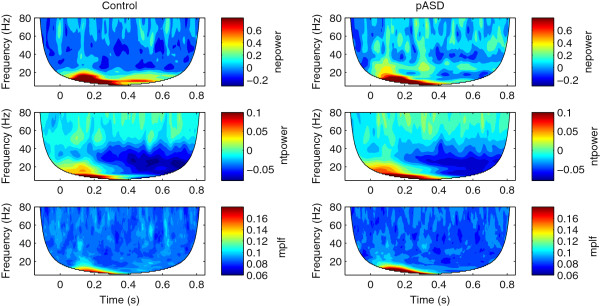
Right hemisphere time-frequency results. Time-frequency plots of the grand average across all ROIs for the control group (left column) and the pASD group (right column) for the right hemisphere. The rows show normalized evoked power (nepower), normalized total power (ntpower) and mean phase locking factor (mplf), respectively. The region in white is not analyzed because of incomplete filling of the wavelet near the edges.